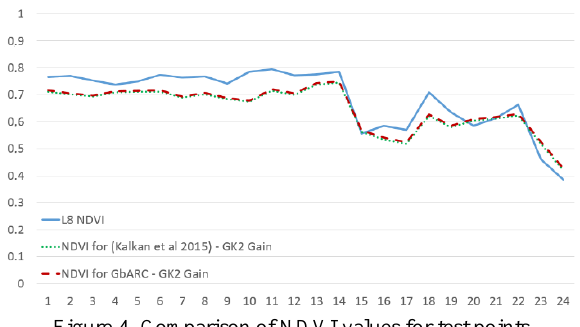
Figure 4. Comparison of NDVI values for test